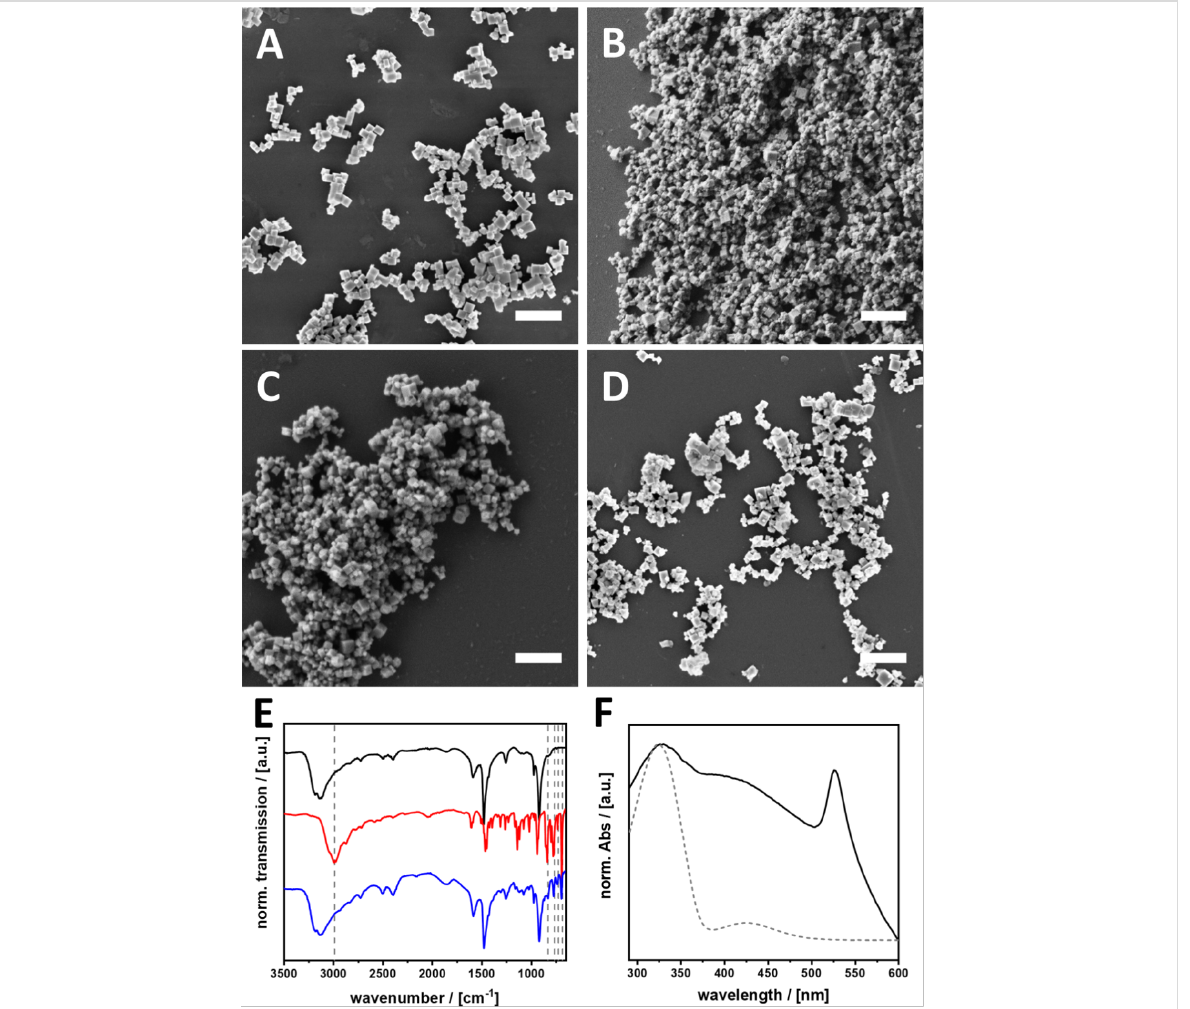
Figure 4: (A–D) SEM images of particles with (A) AzoC 1 , (B) AzoC 2 , (C) AzoOC 4 and (D) AzoOC 12 ligands on the surface, scale bar = 1 µm. (E) FTIR transmission spectrum of non-functionalized CH 3 NH 3 PbBr 3 (black), AzoC 2 (red) and 3D-AzoC 2 (blue). Wave numbers at 2991, 832, 765, 727 and 685 cm − 1 are highlighted in grey as significant vibrations of the azobenzene. (F) Normalized UV–vis absorption spectra of 3D-AzoC 2 dispersed in toluene (black) and AzoC 2 in H 2 O (grey,